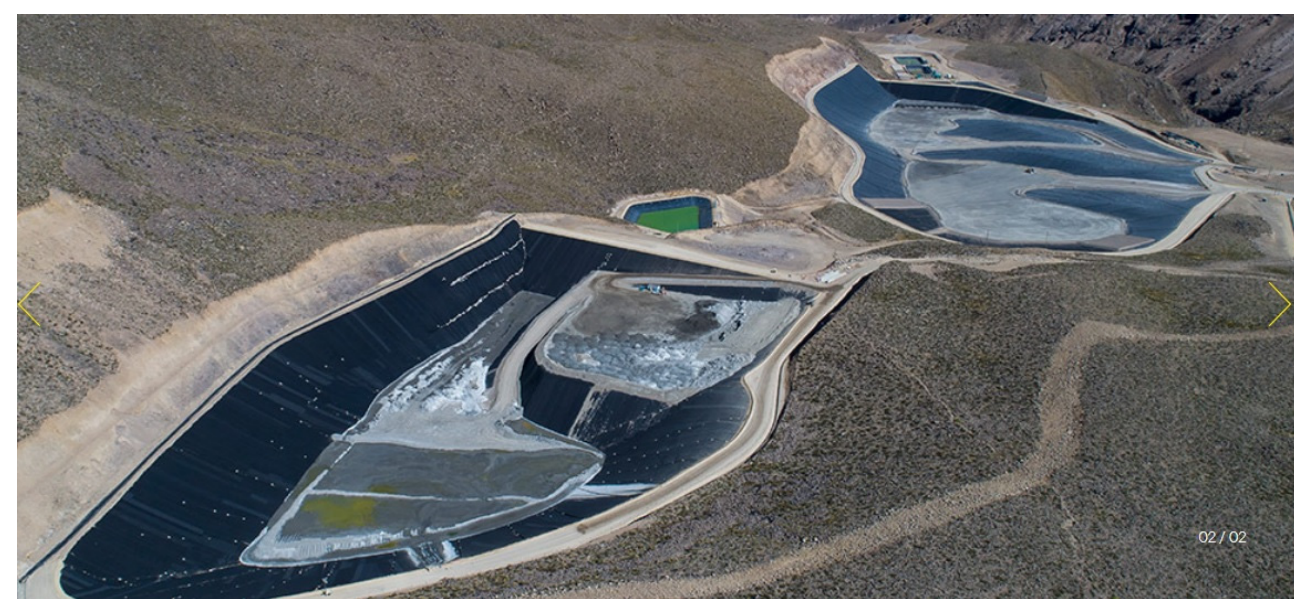
Figure 74. Tambomayo Filtered TSF Normal Operation and Contingency Operation Overview [42,43,71,72].